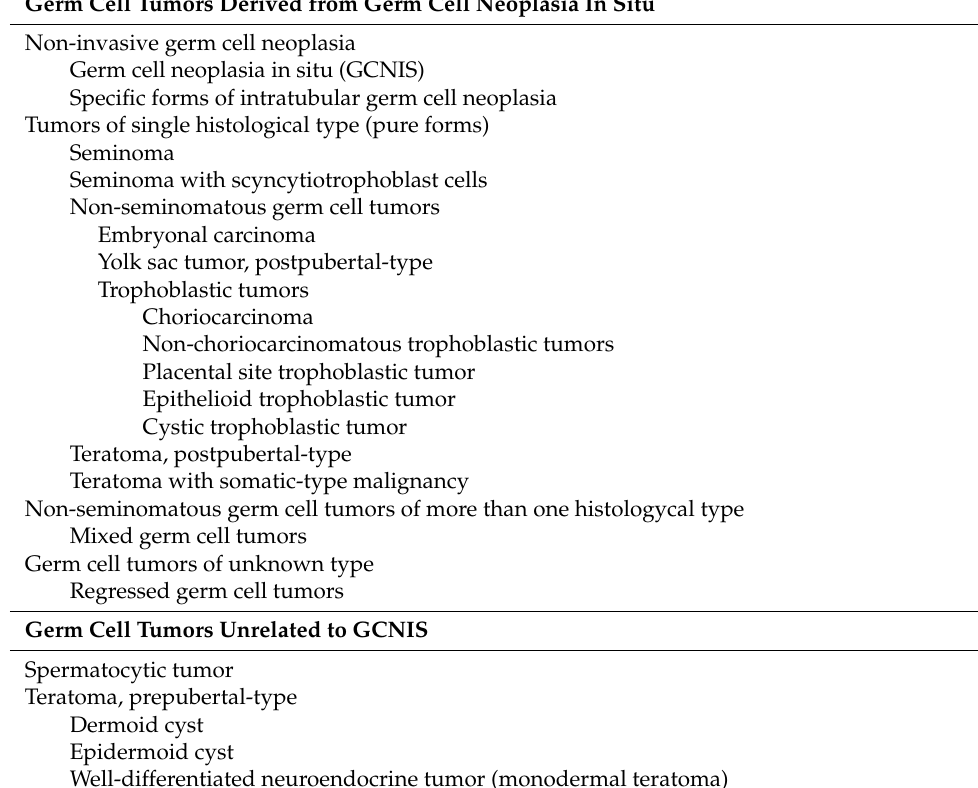
Table 1. World Health Organization (WHO) classification of TGCT, adapted